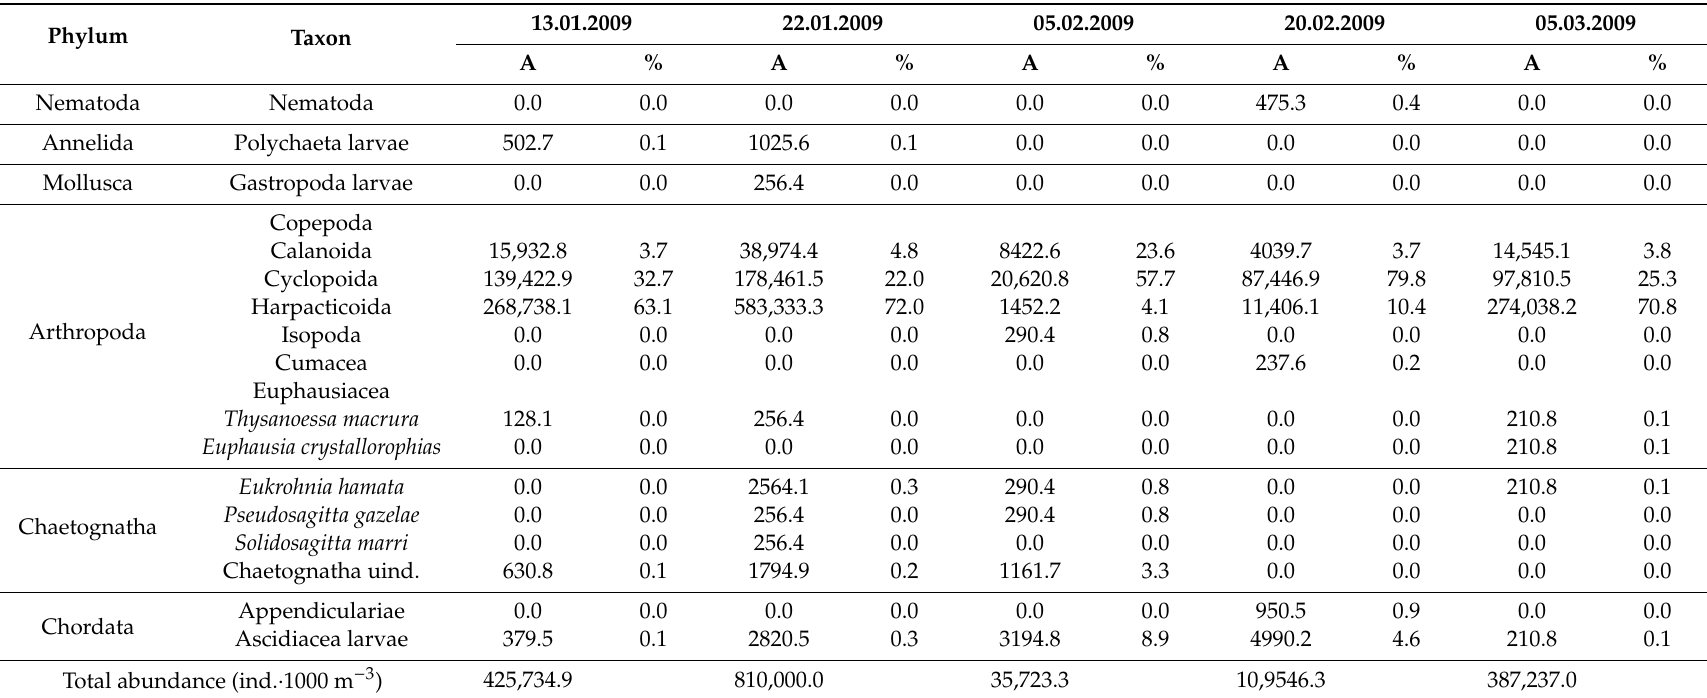
Table 3. Main groups of zooplankton in Herve Cove. (A) Abundance (ind. · 1000 m − 3 ), (%)